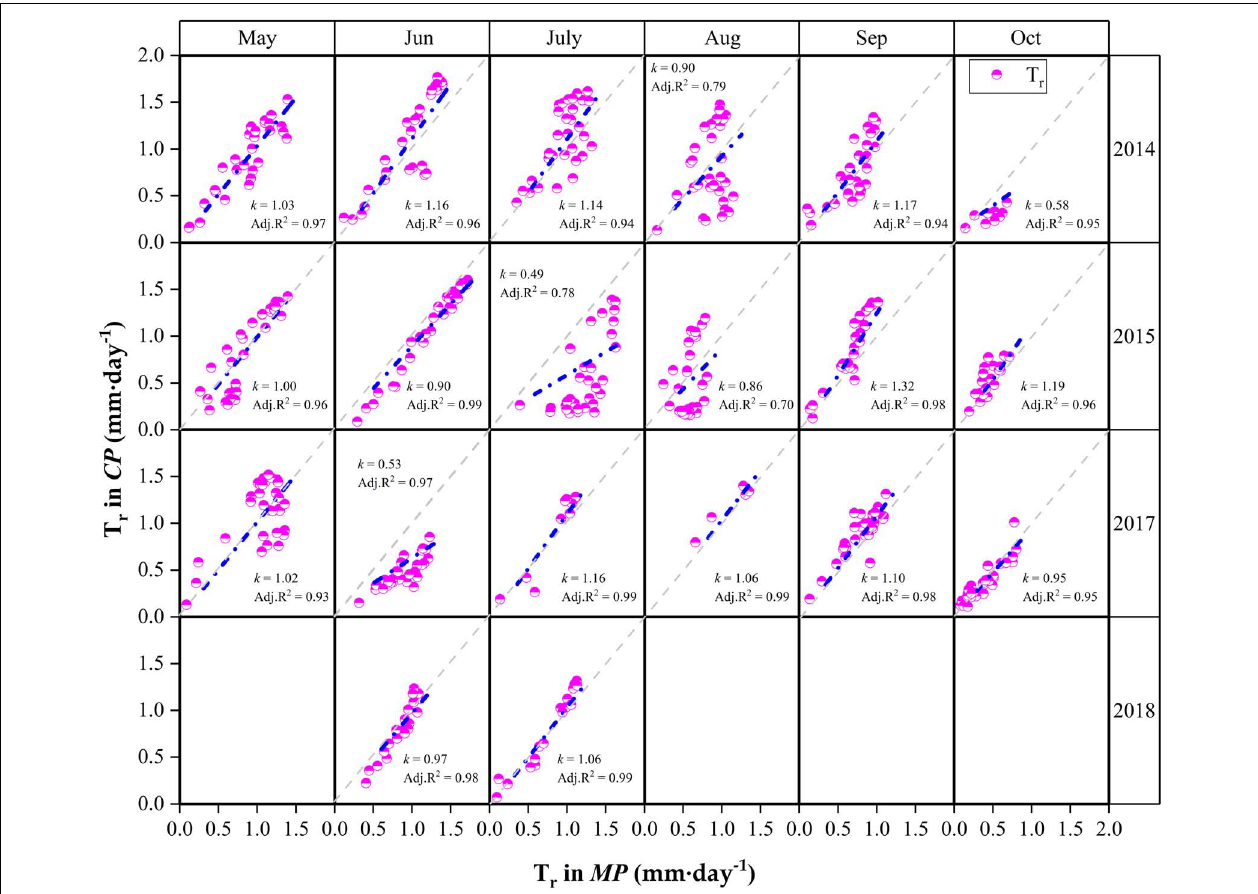
FIGURE 6 | Relationships of canopy transpiration (T r ) between Mongolian Scots pine ( MP ) and Chinese pine ( CP ) in different months during the 4 years of xylem sap flux measurement. k is the slope of the linear regression. The gray dotted lines are 1:1 line. Data in May, August and September in 2018 were lost due to faulty cable in CP sample